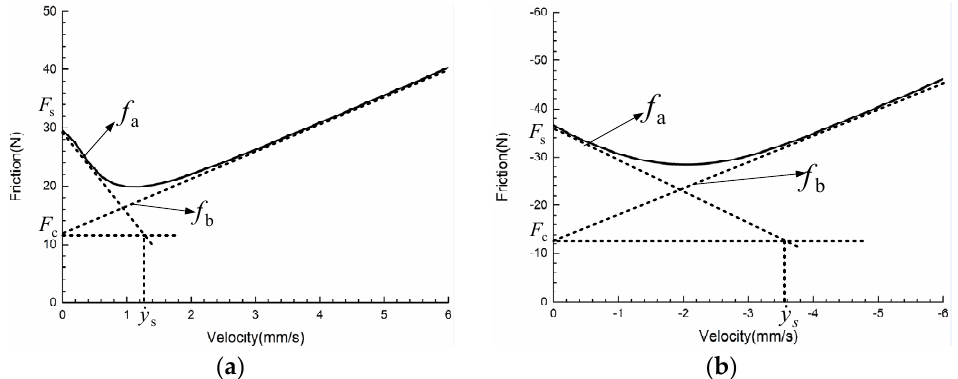
Figure 16. Measurement diagram of frictional force parameters: ( a ) forward movement; ( b ) reverse movement. Table 2. Stribeck friction model parameter values.